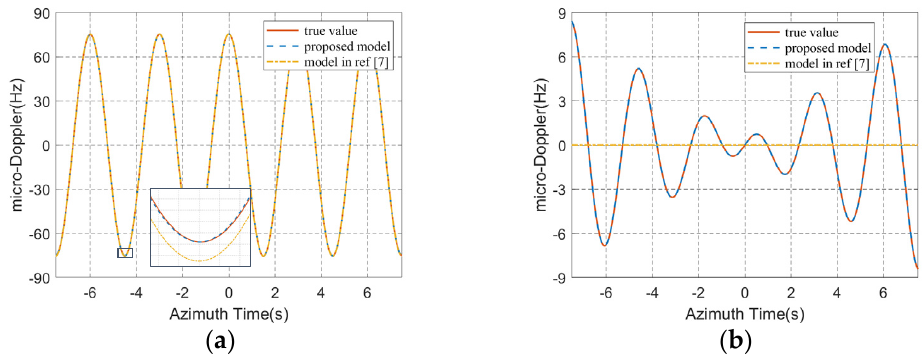
Figure 5. The micro-Doppler introduced by target linear oscillation. ( a ) Oscillating along the range direction; ( b ) oscillating along the azimuth direction.